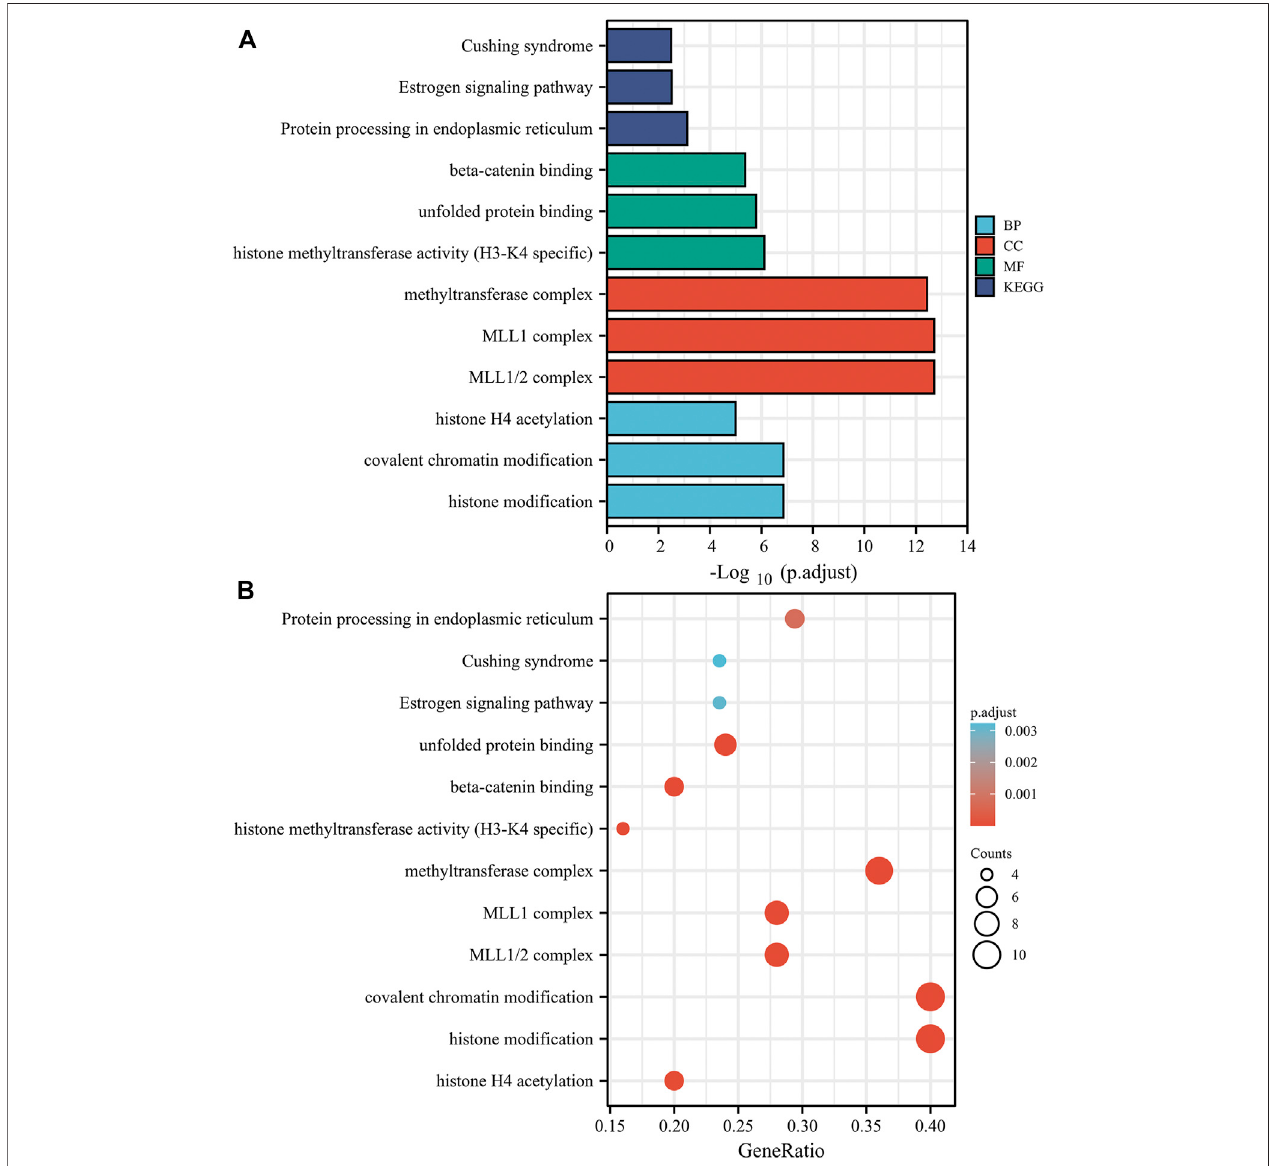
FIGURE 8 | Based on the KDM6B-binding and interacted proteins, the KEGG pathway and GO analysis was performed and shown as bar chart (A) and bubble chart (B) . The top three signi fi cantterms in BPs(biological processes), MFs (molecular functions), and CCs (cellularcomponents) and KEGG pathways areshown inbar chart. The GO analysis revealed that target proteins were mostly enriched in covalent chromatin modi fi cation, histone modi fi cation, and histone H4 acetylation in the BP enrichment analysis; methyltransferase complex, MLL1 complex, and MLL1/2 complex in the CC analysis; and histone methyltransferase activity (H3-K4 speci fi c), modi fi cation-dependentproteinbinding,andunfoldedproteinbindingintheMFanalysis.TheKEGGanalysisindicatedthatthetargetproteinsweresigni fi cantlyenriched in pathways of Cushing syndrome, estrogen signaling pathway, and protein processing in the endoplasmic reticulum.